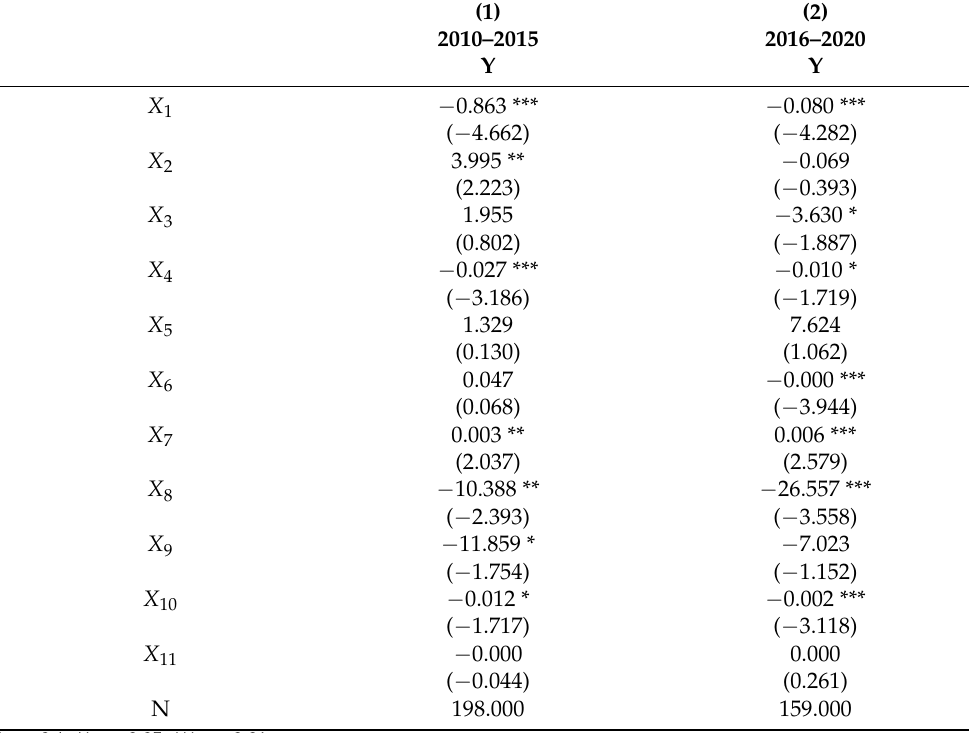
Table 6. Robustness test of the uncoordinated coupling influencing factors of tourism, urbanization, technology, and the ecological